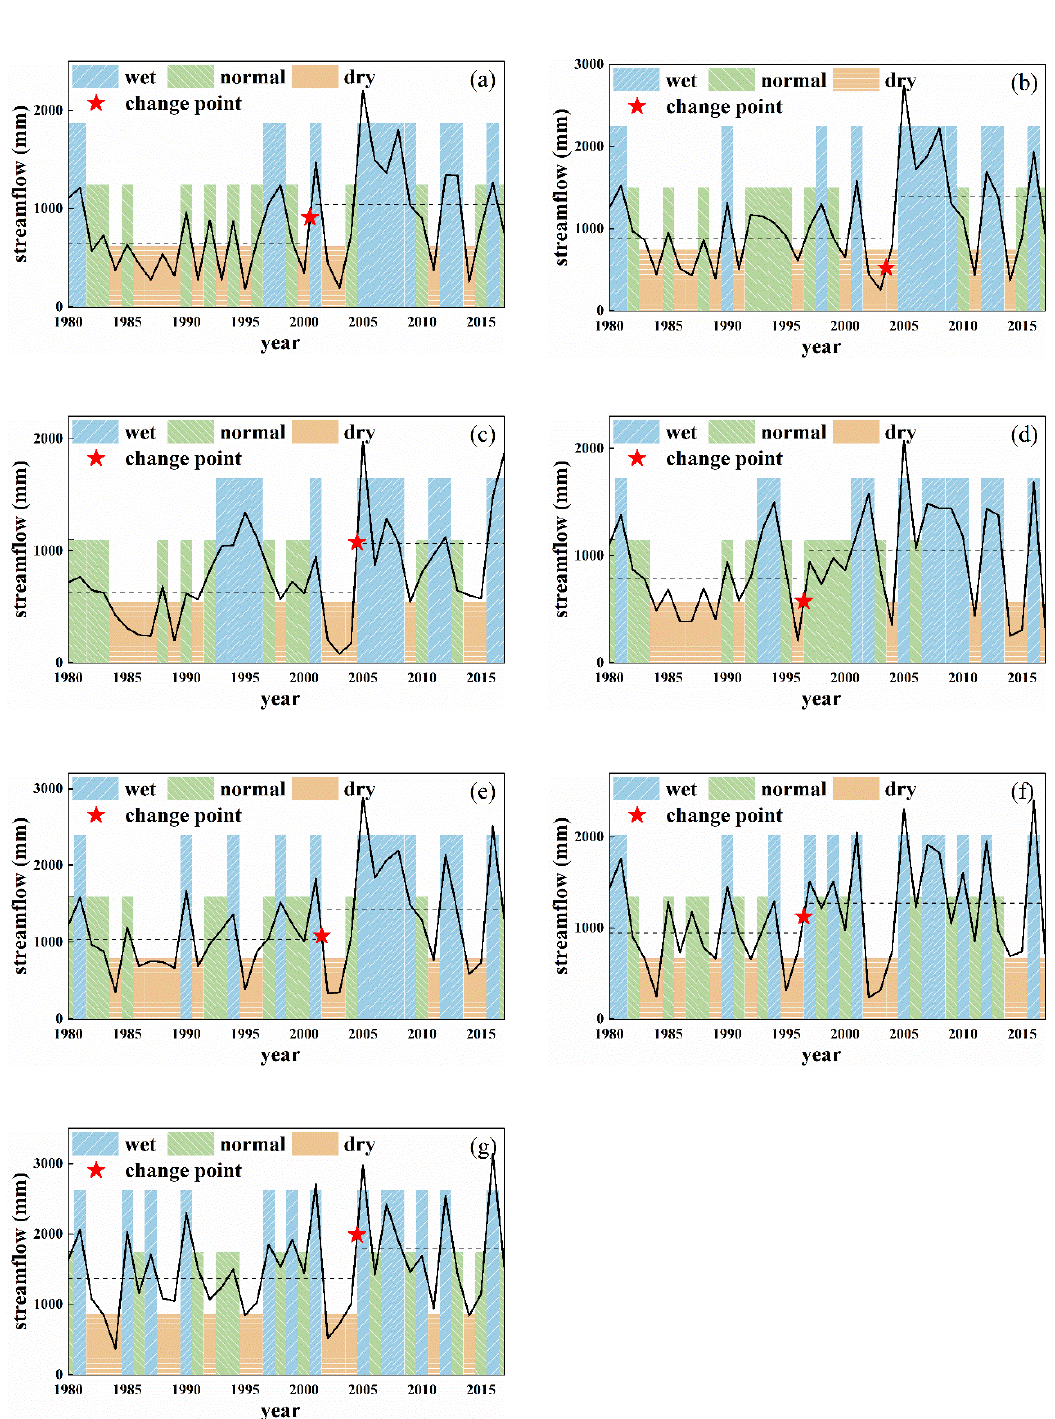
Figure 4. Annual streamflow comparison of pre- and post- period in each river basin. Distribution of wet (largest 30%) / normal / dry (smallest 30%) periods are also shown, ( a ) Bazhang River Basin, ( b ) Zengwen River Basin, ( c ) Yanshui River Basin, ( d ) Erren River Basin, ( e ) Gaoping River Basin, ( f ) Donggang River Basin, ( g ) Linbain River Basin.